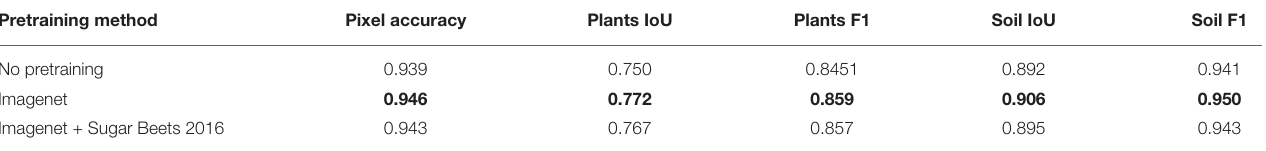
TABLE 8 | Influence of pretrained weights from the Imagenet and 2016 Sugar Beets dataset for transfer learning. Pretraining